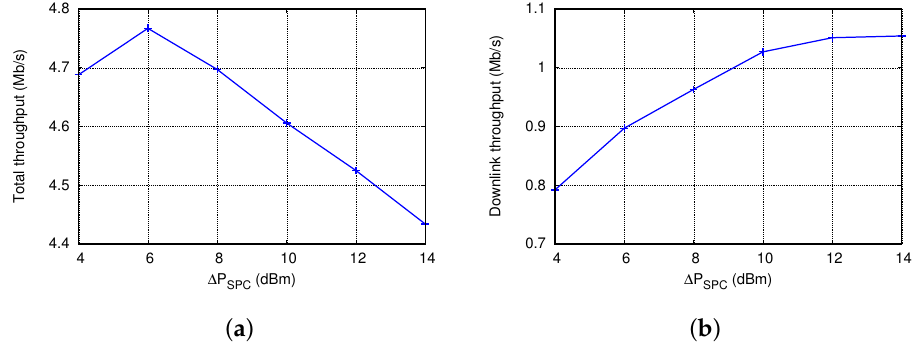
Figure 6. Effect of additional transmission power in the supplemental power control scheme ( ∆ P SPC ) on ( a ) total throughput and ( b ) downlink